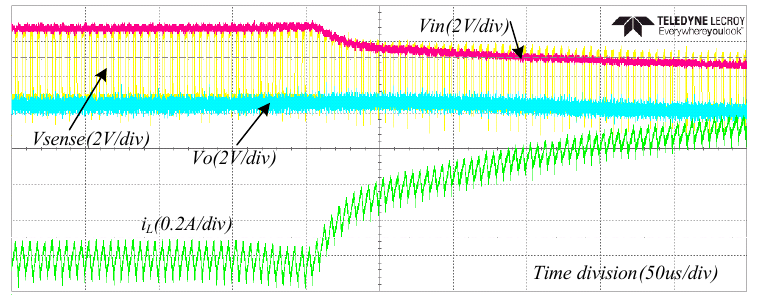
Figure 14. Experimental waveforms for the current, estimated input and output voltages and the sensed voltage as highlighted in Figure 5 during transient dynamics.